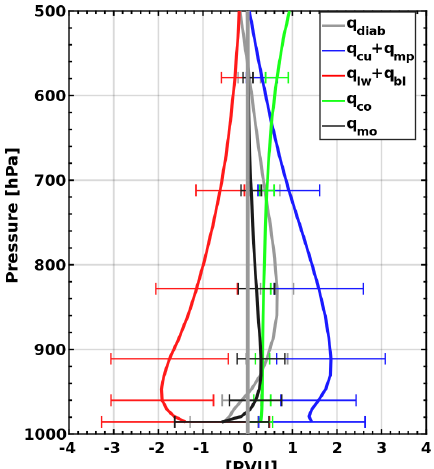
Figure 8. Average vertical profiles of PV tracers for all 100 simula- tions, averaged within a 100km radius around the cyclone centres. Whisker length equals twice the standard deviation.